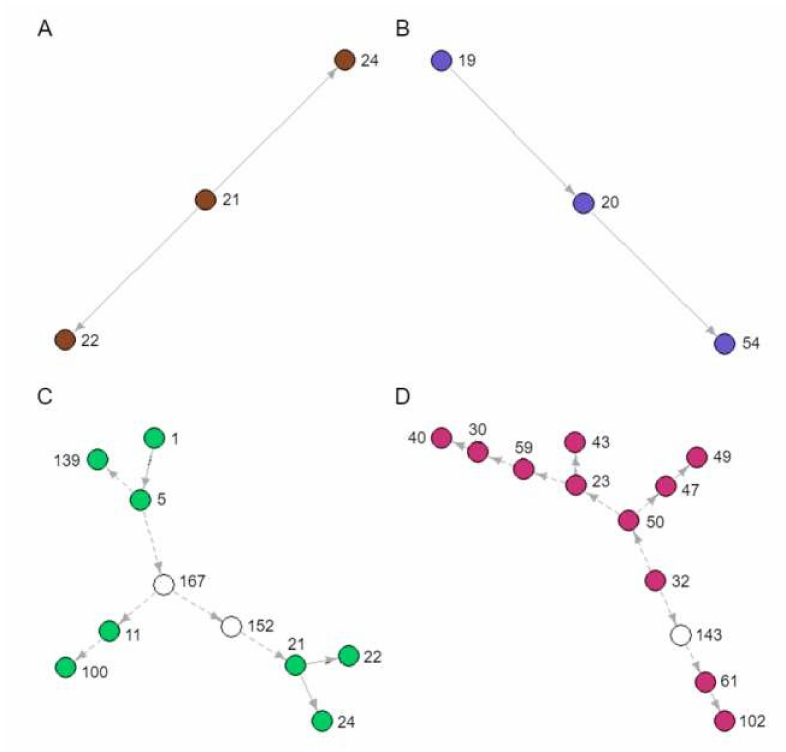
Figure 4. Novel transmission clusters ( A , B , C and D ) identified from the transmission tree in Figure 3. Each node represents a sampled patient from the SAC database, and each arrow a directed transmission relationship. Coloured nodes represent sampled patients and indicate the corresponding coloured boxes in Figure 3. White nodes represent predicted unsampled patients. Solid arrows represent transmission relationships already known to the SAC, whereas dashed arrows represent novel inferences of